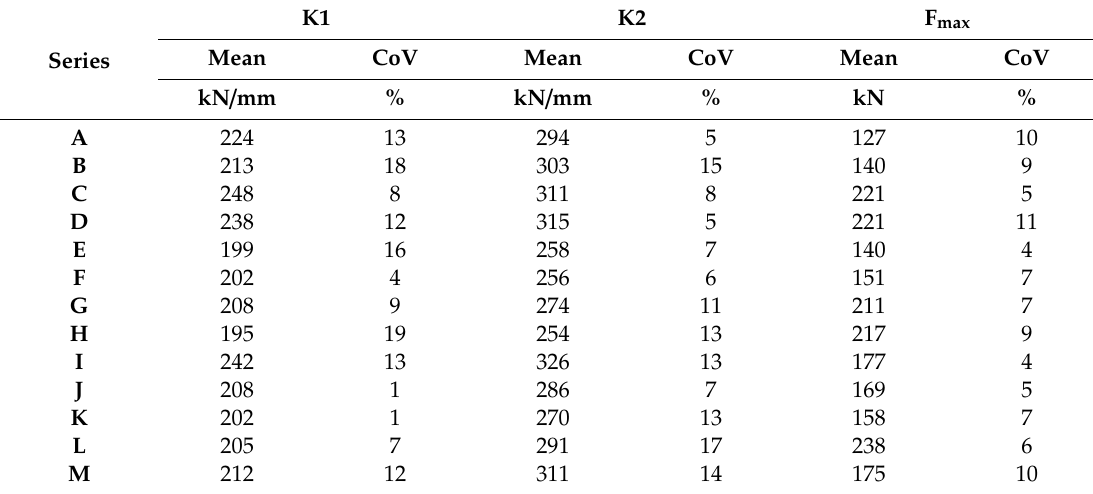
Table 3. Summary of tested